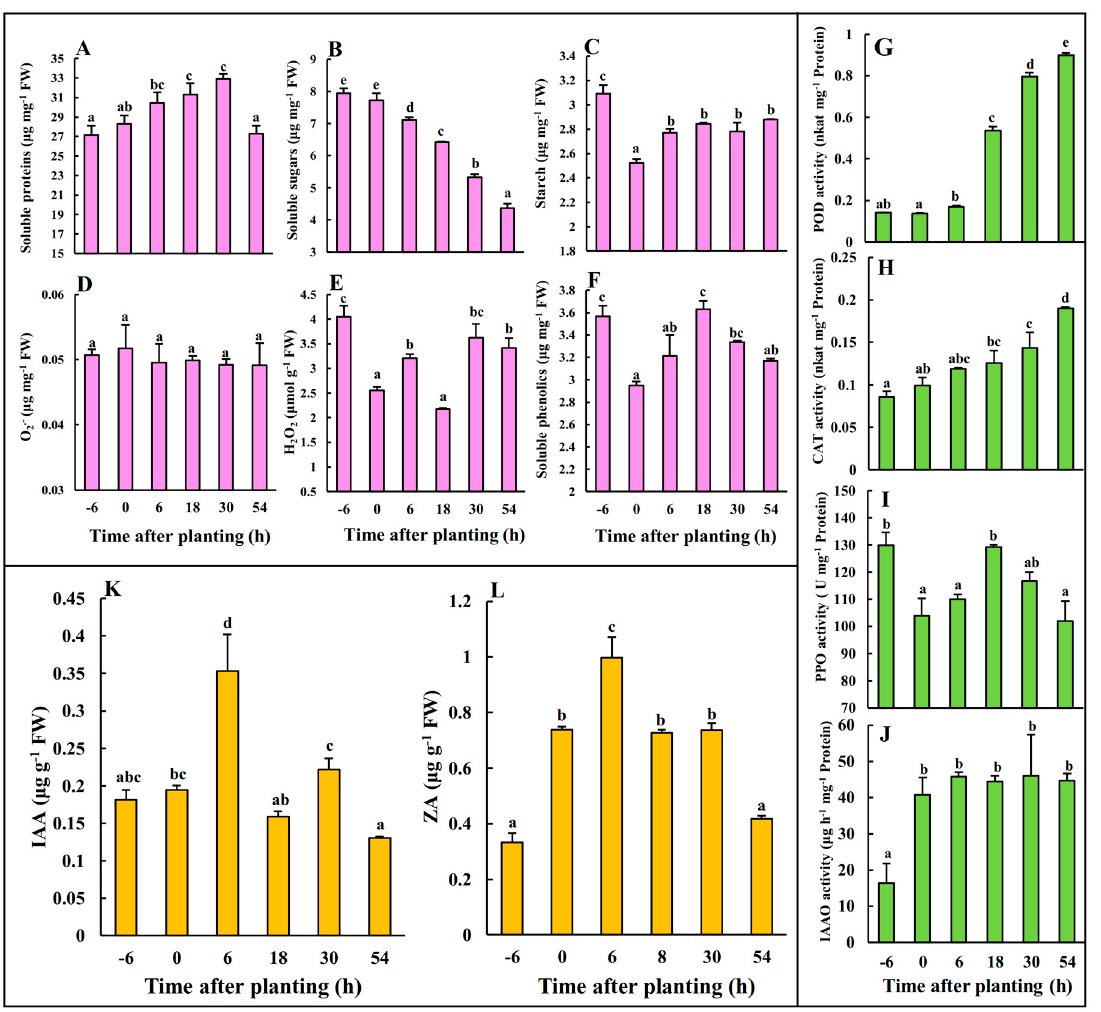
Figure 1. The dynamic changes of the concentrations of rooting-related metabolites including soluble proteins ( A ), soluble sugars ( B ), starch ( C ), O 2 •− ( D ), H 2 O 2 ( E ) and soluble phenolics ( F ), enzyme activities of POD ( G ), CAT ( H ), PPO ( I ) and IAAO ( J ), and phytohormones IAA ( K ) and ZA ( L ) during